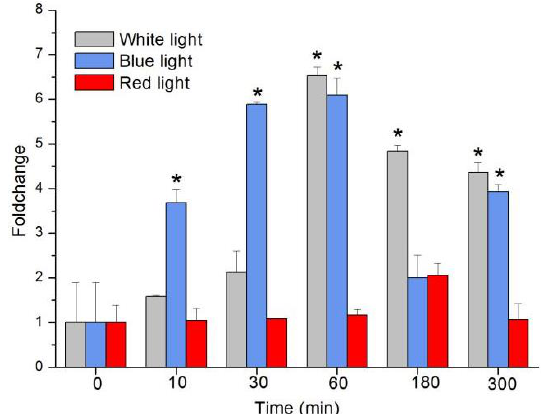
Figure 3. Transcription changes of sjCRY-DASH induced by white light, blue light, and red light. Transcription accumulation was quantified by qRT-PCR. The changes in transcript levels after exposure to different light conditions are presented as fold changes relative to the RNA from dark-grown sporophytes. Each test was performed in six biological samples. The data in the figures represent the averages ± standard deviation. Data were analyzed by two-way ANOVA followed by Turkey’s multiple comparison test. * p < 0.05.